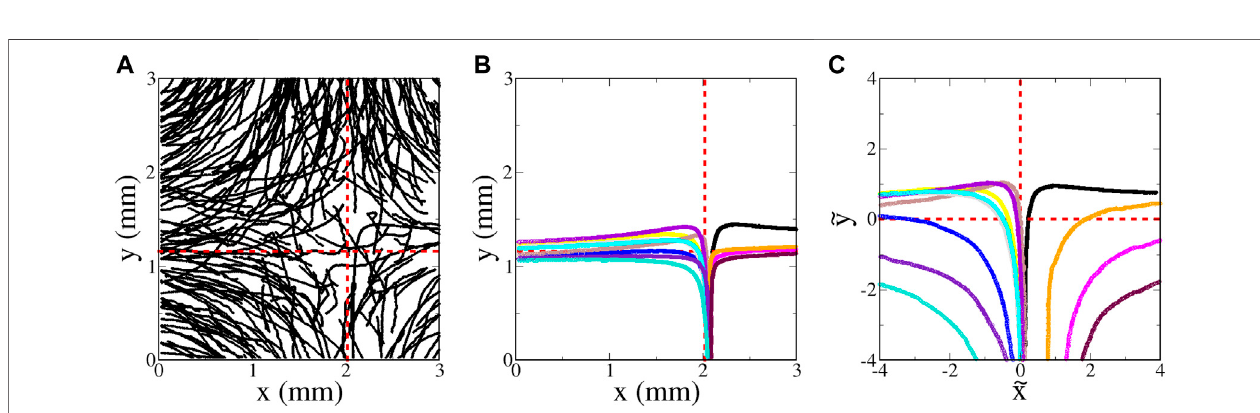
FIGURE 12 | Tetraselmis swimming in a hyperbolic fl ow with A = 3.6 s − 1 ( fl ow 0.100 ml/min). (A) Random sampling of a very small subset of the trajectories. (B) Samplingoftwelveofthelongest-durationtrajectorieswithminimaltumblingthatenteredfromthebottom. (C) Same as (B) ,butplottedusingnon-dimensionalvariables ~ x and ~ y . In all three panels, the red dashed lines show the location of the passive invariant manifolds going through the passive fi xed point of the hyperbolic fl ow.